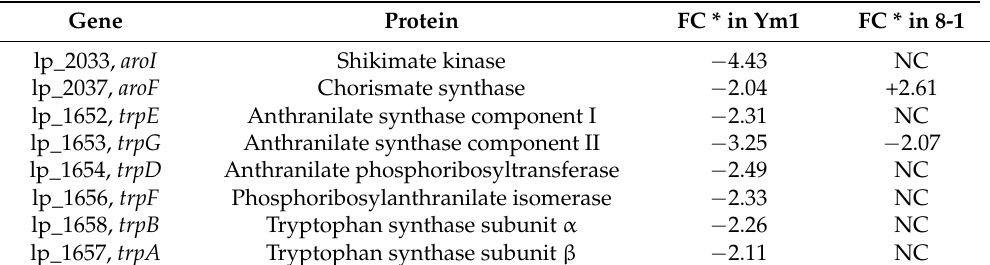
Table 3. Differentially expressed genes (DEGs) connected with tryptophan biosynthesis in L. plan- tarum strains under butanol stress.